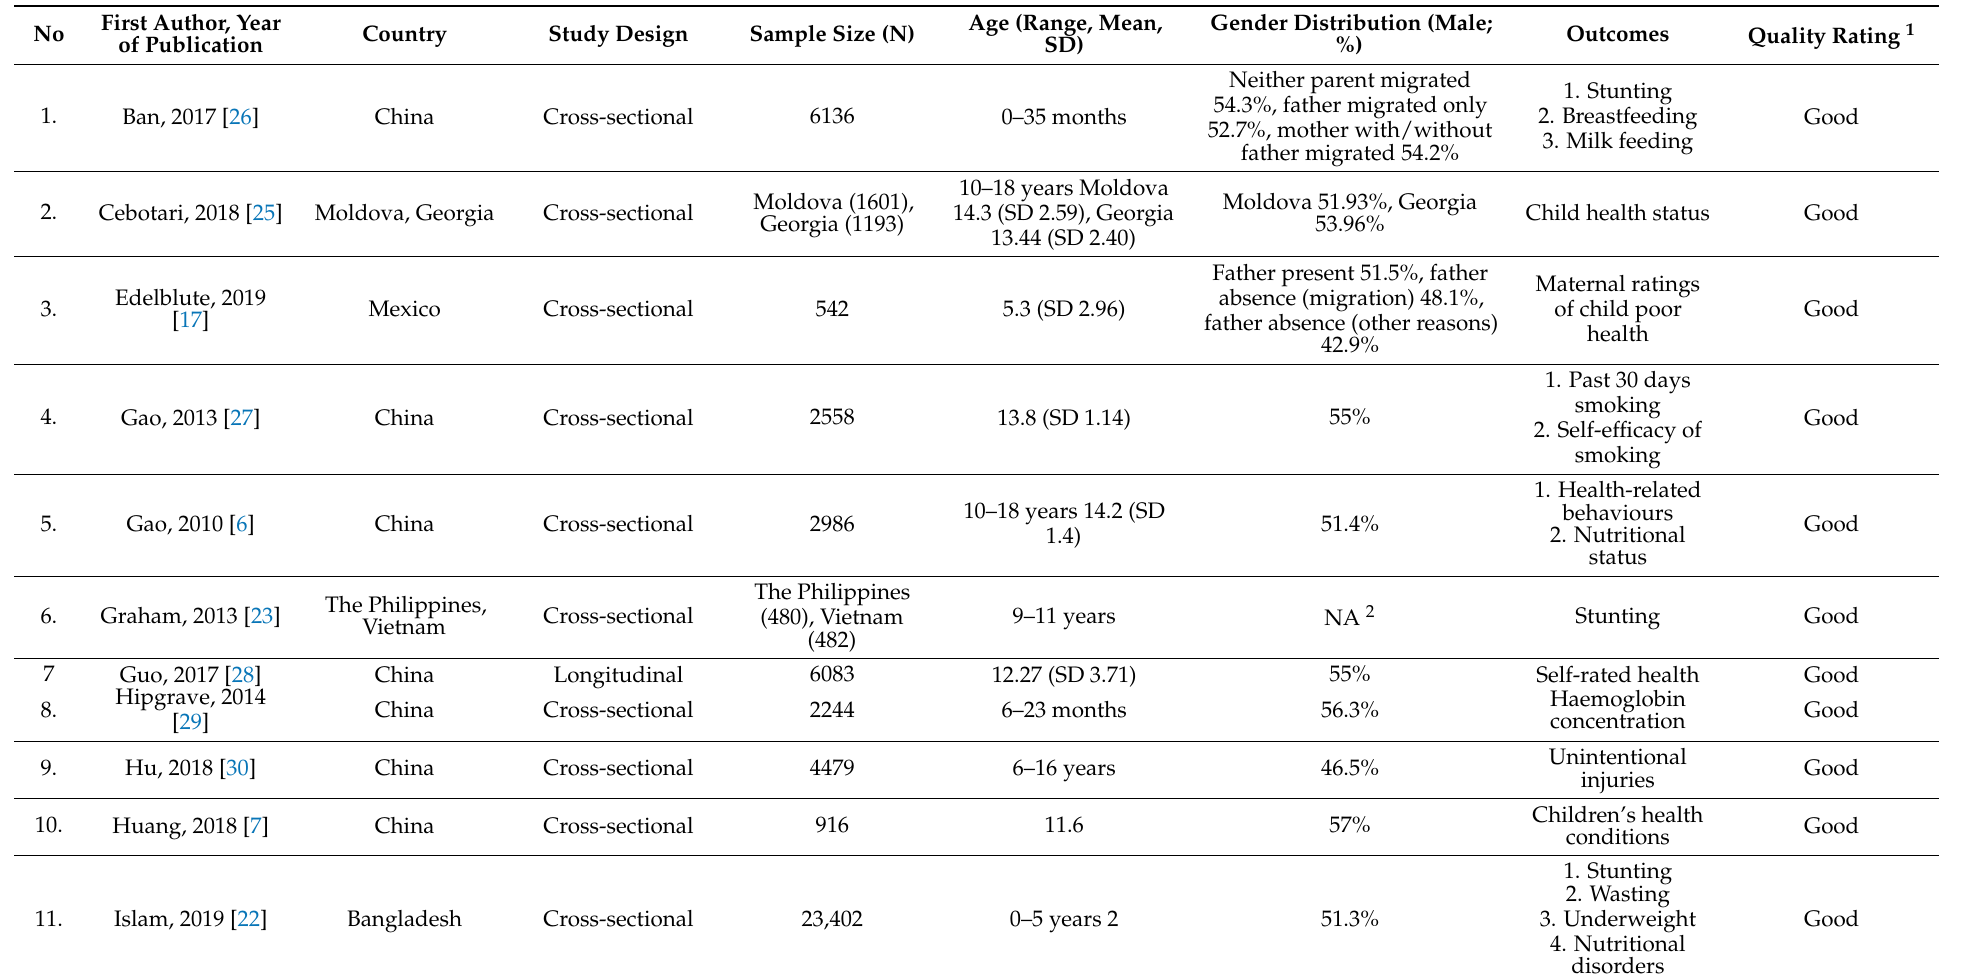
Table 1. Characteristics of the